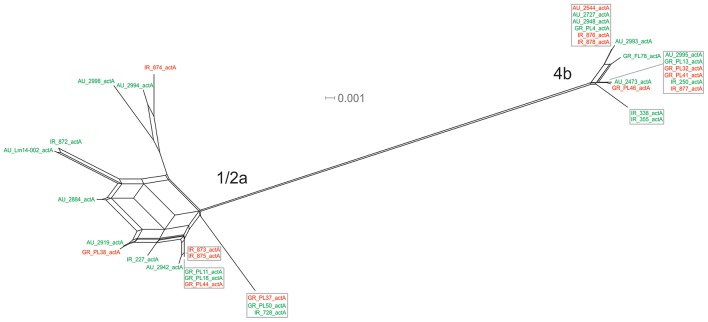
Phylogenetic network applied to virulence gene actA using the Neighbor-Net algorithm. L. monocytogenes strains represented food environment isolates (green color) or clinical isolates (red color), isolated in Ireland (IR), Greece (GR), and Australia (AU). Strains clustered together in a box represent identical nucleotide sequence.